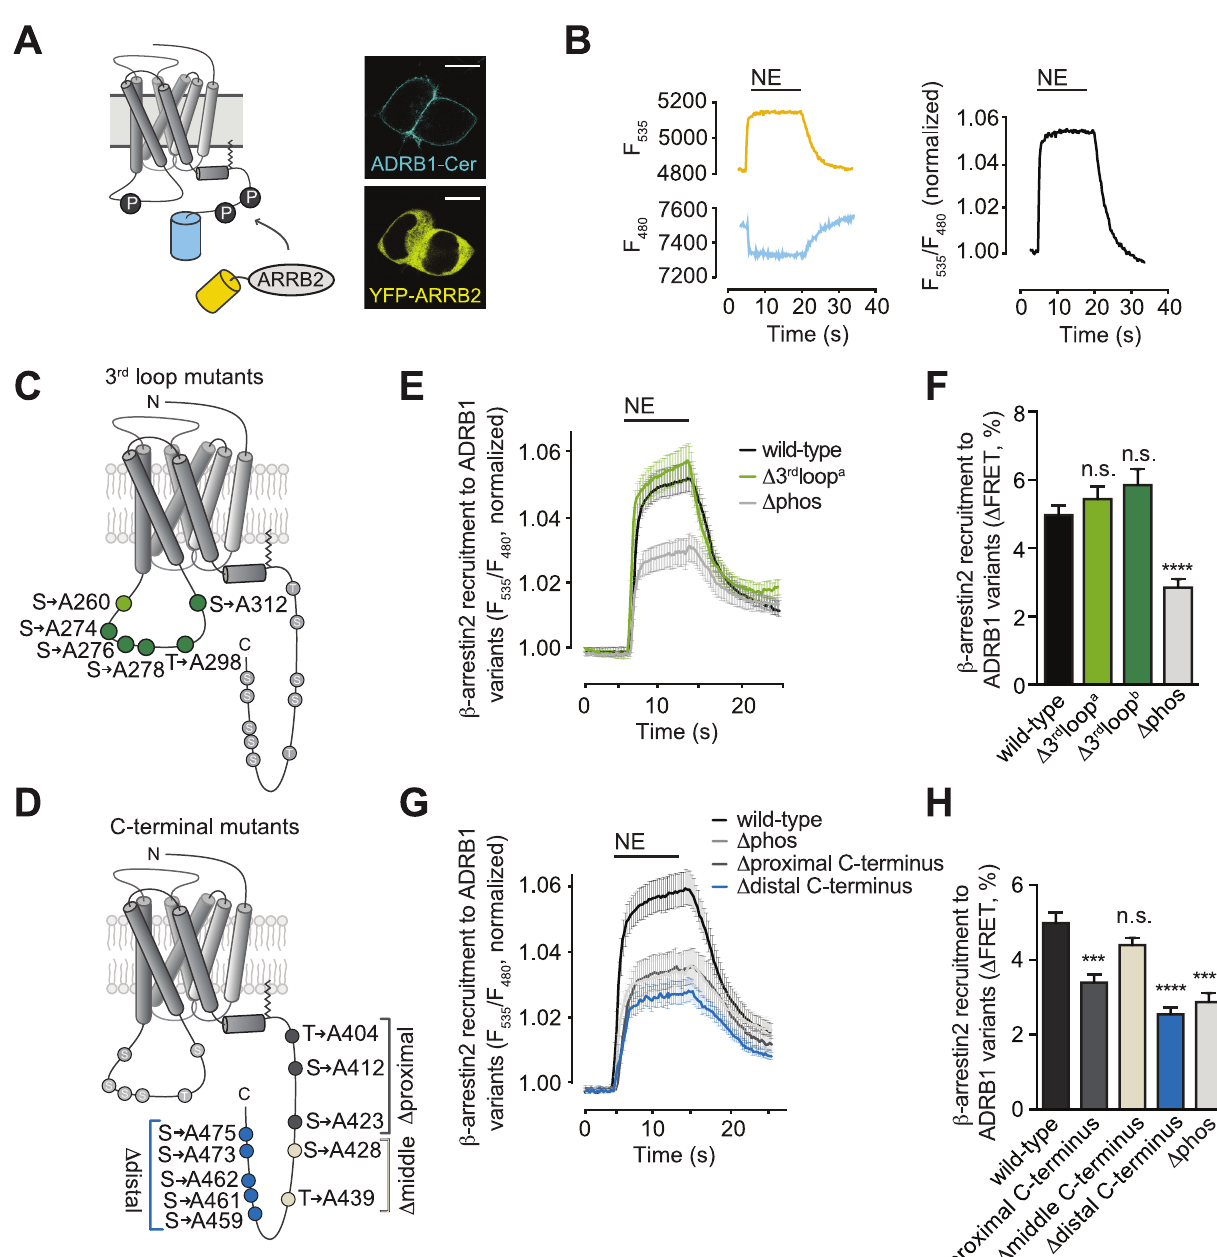
Fig 2. Phosphorylation sites in the C-terminus are crucial for β -arrestin2 recruitment. ( A ) Schematic of the FRET assay for β -arrestin2 recruitment (left) and confocalmicroscopyof representative cells expressingCerulean-taggedADRB1 and YFP-tagged β -arrestin2(right, scale = 10 μ m). ( B ) Representative tracings (left) and their ratiometric representation (right) of simultaneous recordingof emissions from YFP (535 nm) and Cerulean(480 nm) upon stimulation of cells with norepinephrine (NE, 10 μ M). ( C, D ) Schematics of the human ADRB1 highlightingthe phosphosites mutated in the third intracellularloop and the C-terminus. ( E ) Averaged FRET tracings comparing wild-type ADRB1, ADRB1 Δ 3rdloop a (= ADRB1(Ala260), light green) and a mutant devoid of all phosphosites in the third intracellularloop and C- terminus (ADRB1 Δ phos). ( F ) Quantification of NE-induced changesof receptor-arrestin FRET obtainedfor the ADRB1 variants depictedin (C). ( G, H ) Analogousexperiments as in (E, F) for C-terminal mutants. Data are means ± SEM from (cid:21) 10 tracings (E, G) and (cid:21) 30 cells (F, H). Kruskal-Wallis-Test with Dunn‘spost test. *** p (cid:20) 0.001 vs. wild-type and n.s. = not significant.